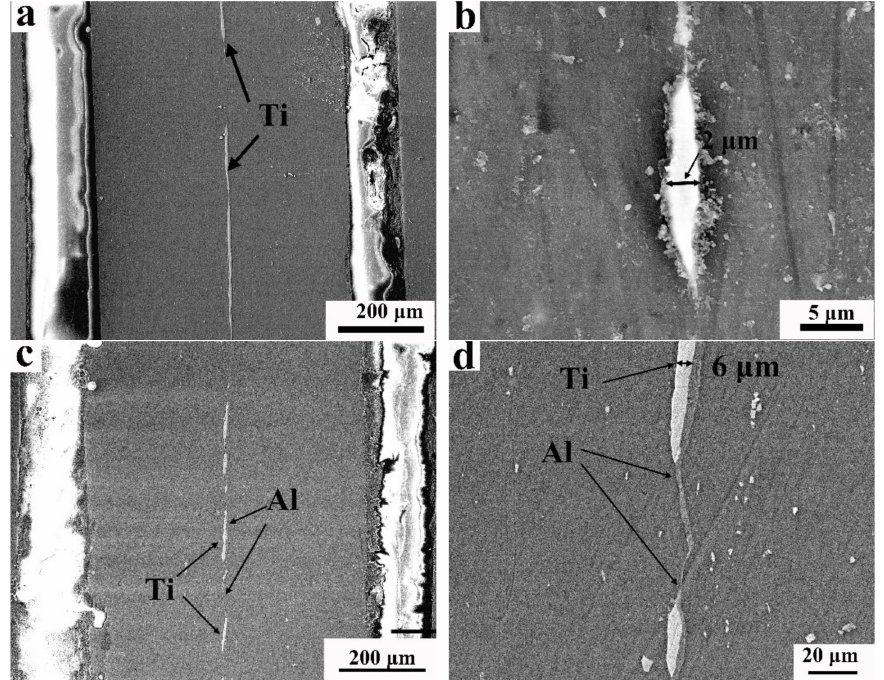
Figure 10. SEM images of cross-section of 0.01Ti and 0.01Ti-0.01Al sheets: ( a , b ) SEM image of 0.01Ti sheet; ( c , d ) SEM image of 0.01Ti-0.01Al sheet.